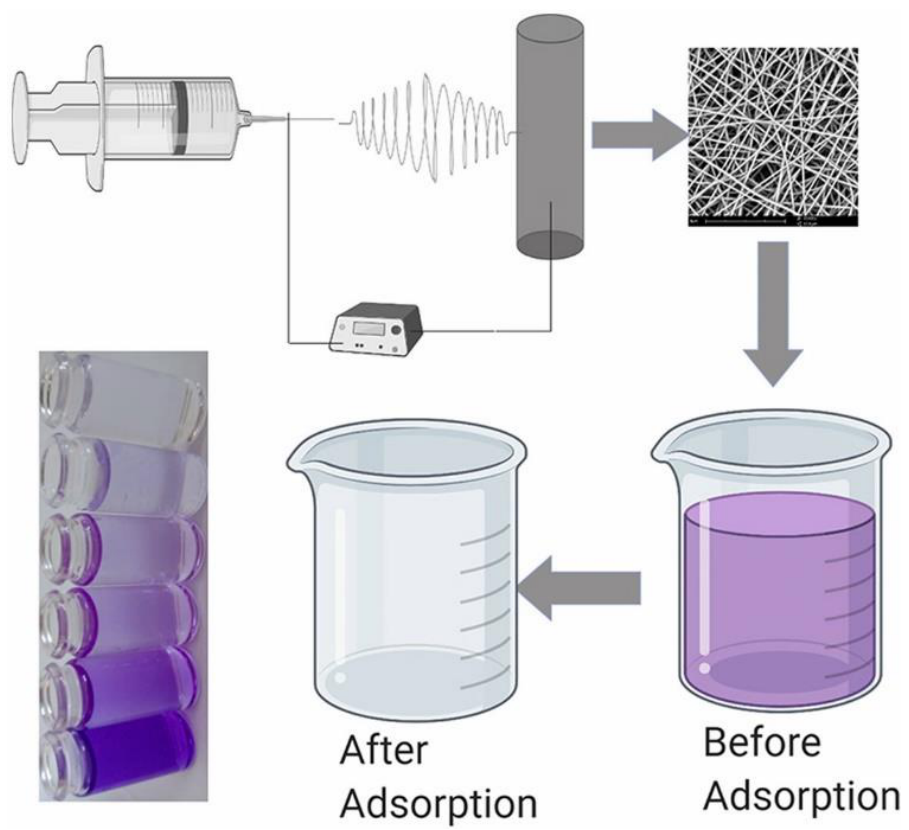
Figure 6. Pebax-based nanocomposite fibrous membranes fabricated by melt electrospinning and applied to dye removal (from ref. [50]).